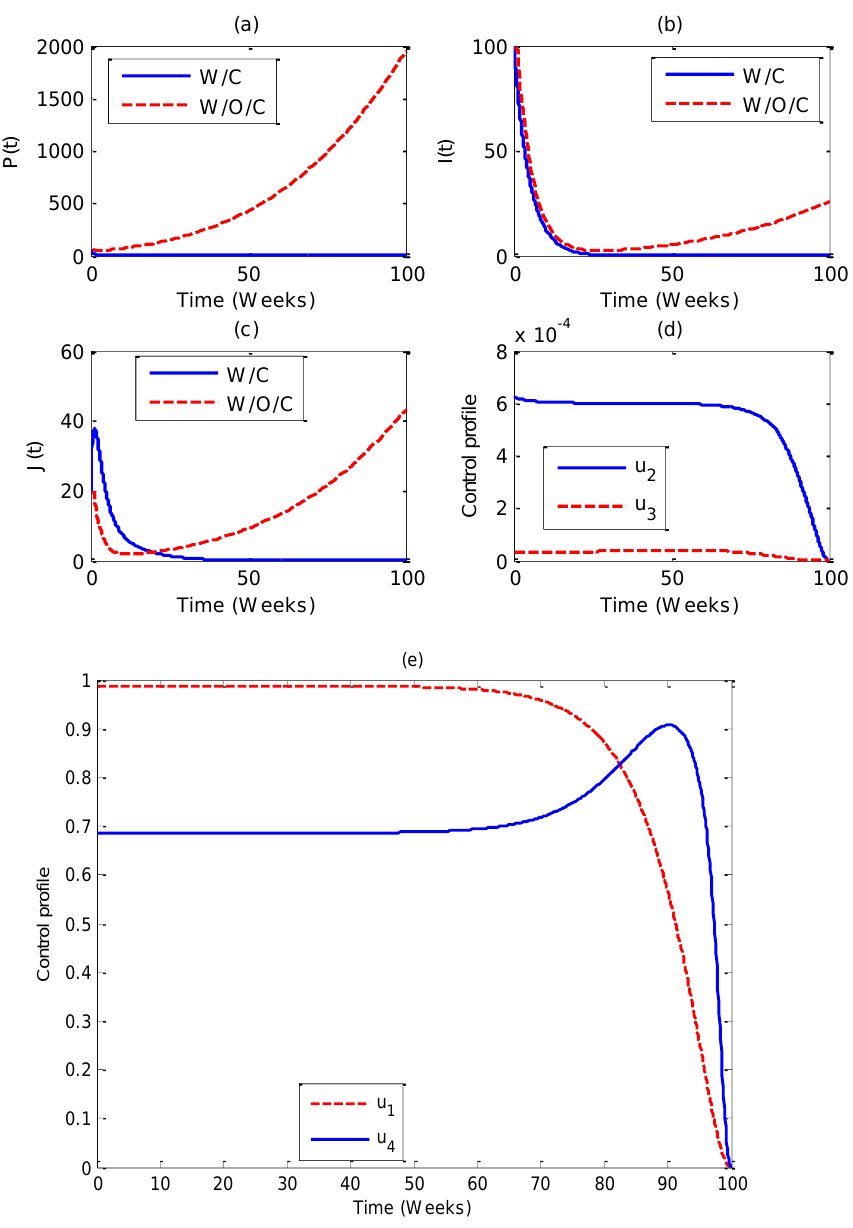
Figure 4. The population dynamics of (a) infected persons in the prodromal stage, 𝑃(𝑡) , (b) infected persons in the rash stage, 𝐼(𝑡) , (c) Isolated persons, 𝐽(𝑡) , (d) Controls, 𝑢 , and (e) Controls, 𝑢 . Here, W/C means “With Control” while W/O/C means 𝑢 , 𝑢 3 1 4 “Without